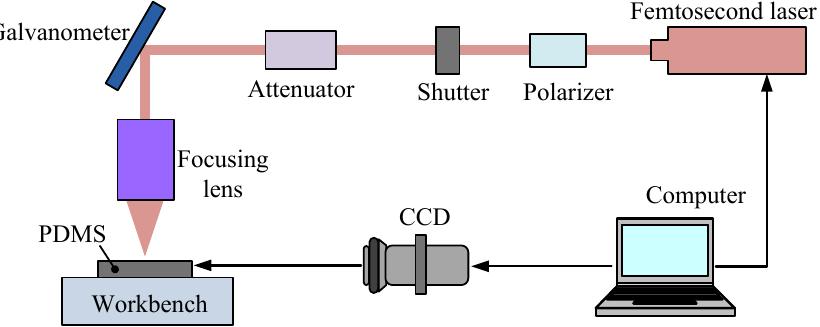
Figure 3. Schematic diagram of the experimental setup for femtosecond laser ablation of PDMS. The detailed processing parameters for femtosecond laser ablation through holes on PDMS film are listed in Table 2. The femtosecond laser with laser spot diameter of 12 μ m and laser pulse frequency of 100 kHz was used to process the PDMS film with thickness of 150 μ m. Table 2. The processing parameters for femtosecond laser through-holes on PDMS.